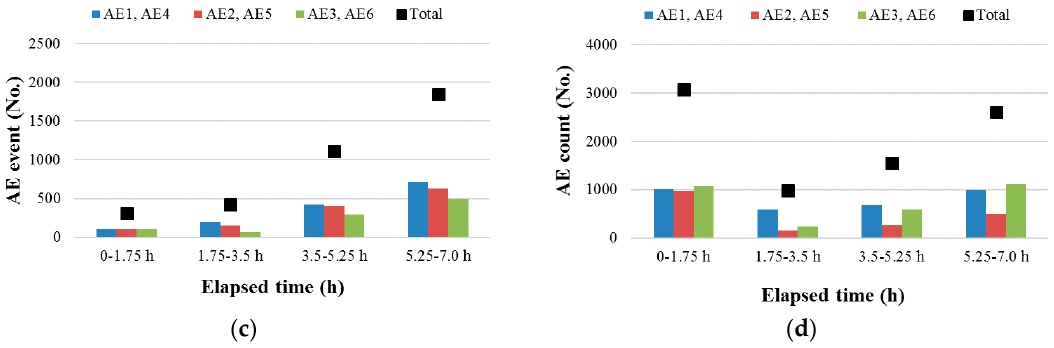
Figure 8. Monitoring results of AE activities: ( a ) AE events (experiment 1); ( b ) AE counts (experiment 1); ( c ) AE events (experiment 2); ( d ) AE counts (experiment 2).